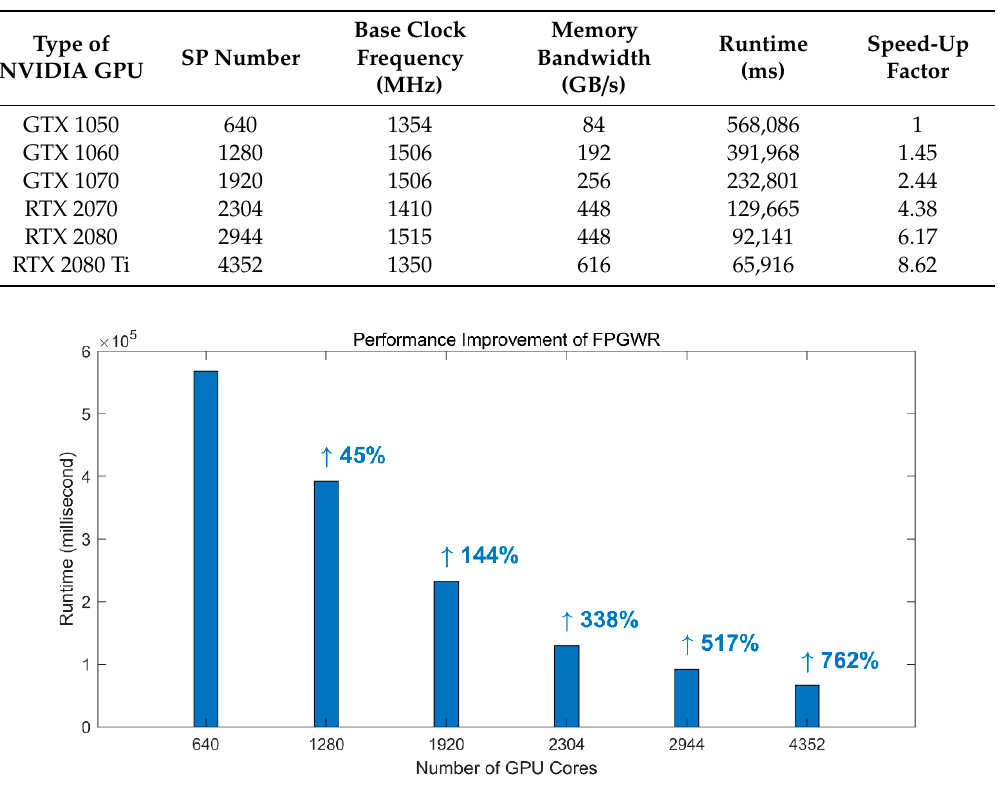
Table 4. Runtime (in seconds) for five GWR packages using different numbers of data points. Number of Data Points FPGWR